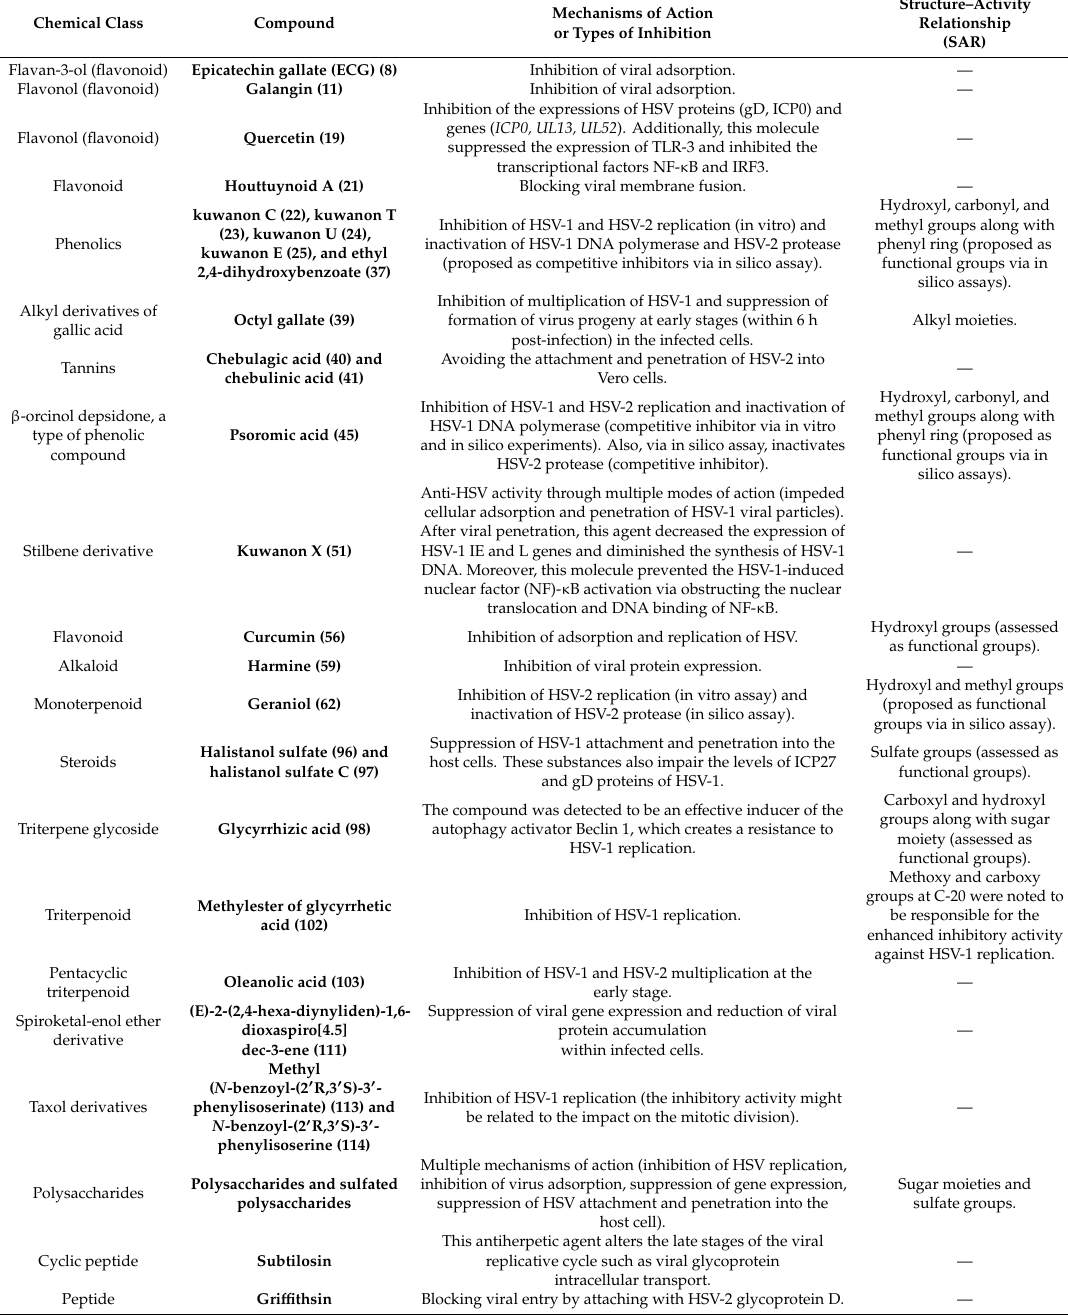
Table 7. Bioactive natural products reported as inducing potent anti-HSV